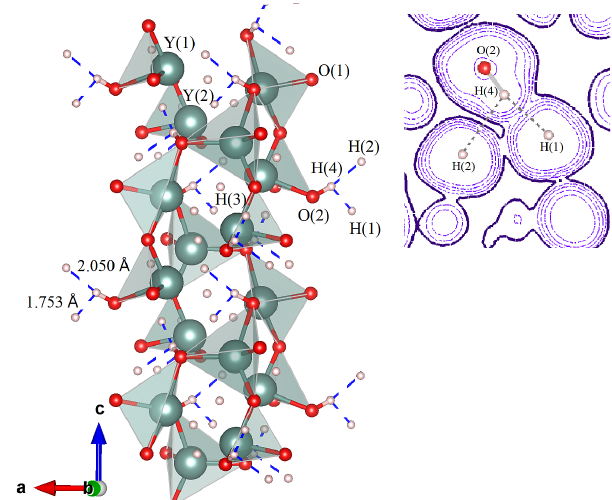
Figure 5. Chains of yttrium polyhedral units linked by dihydrogen bonds in the Y 2 H 3 O(OH) crystal structure: The blue dashed lines denote the relevant H · · · H contacts. The color codes of atoms are the same as in Figure 2. At the right, 2 D contour plot of the valence electron density, calculated at ELF = 0.8475, presents O(2) − H(4) · · · H(1) and O(2) − H(4) · · · H(2) dihydrogen bonding connections. According to the AIM protocol for charge densities, the minimum distances to a zero flux surface are located at distances of about 0.809, 0.816, and 0.159 Å for the H(1), H(2), and H(4) sites,